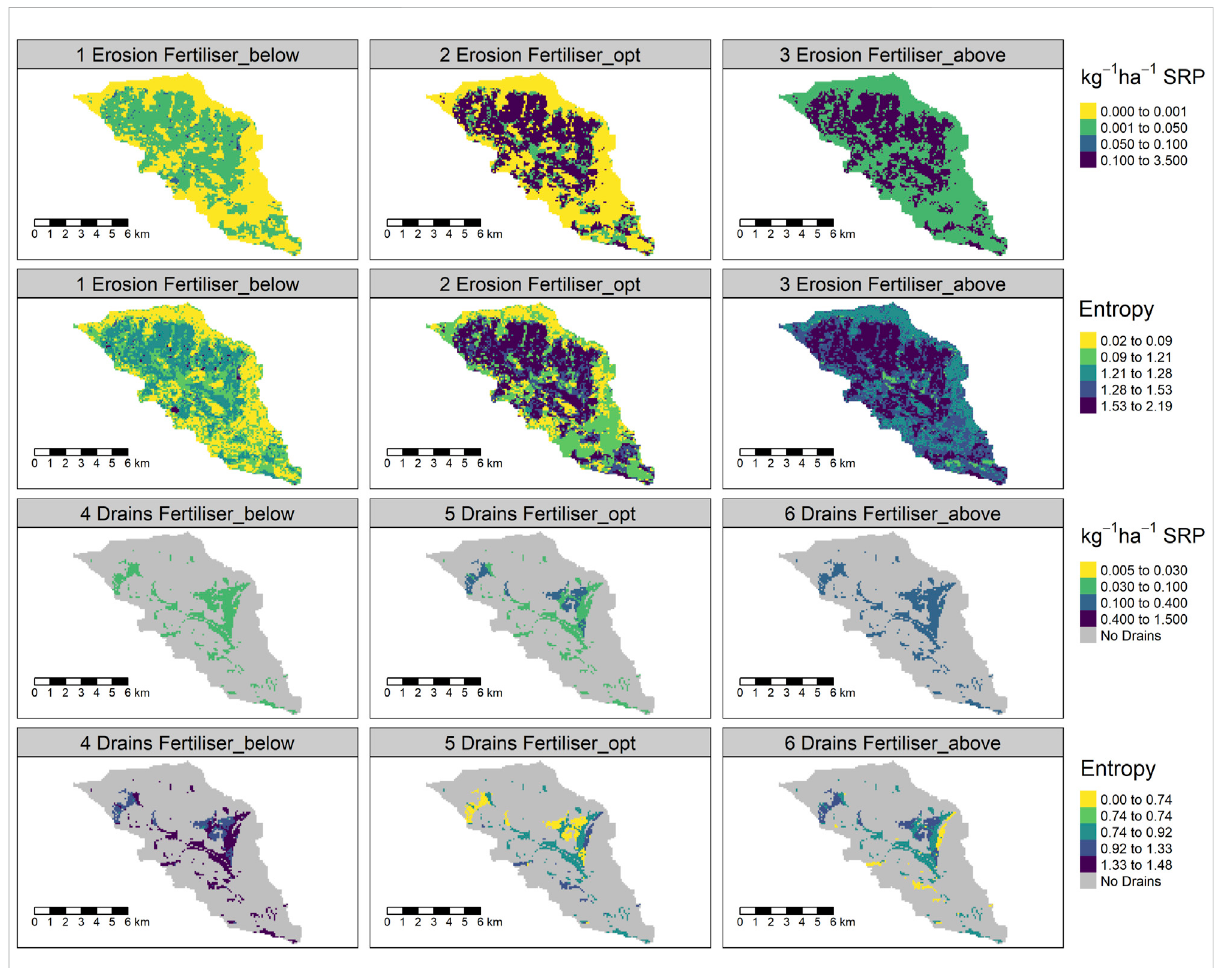
FIGURE 8 Erosion losses and drain losses in the Tarland study catchment under three fertiliser management scenarios below, at and above agronomic optimum and the associated uncertainty